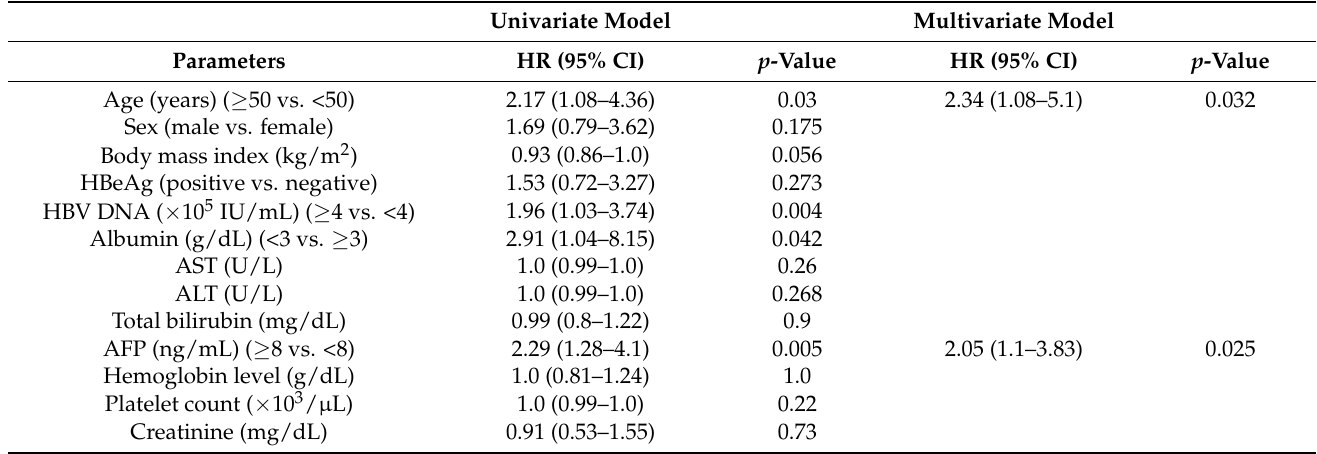
Table 2. Predictors of hepatocellular carcinoma according to univariate and multivariate Cox regression models.